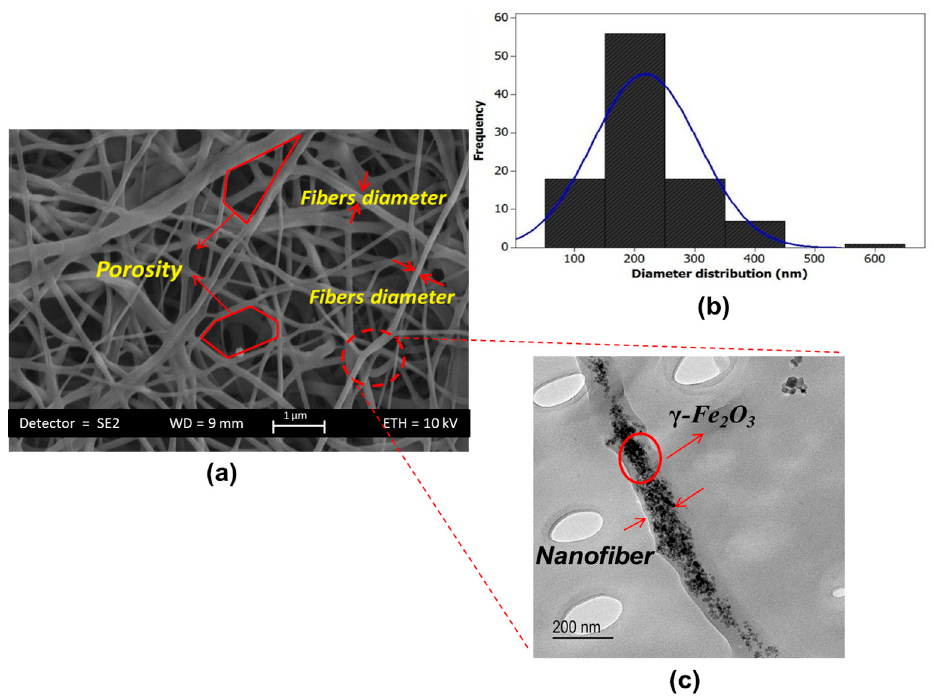
Figure 6. ( a ) FE-SEM image of TPU/PLLA-( γ -Fe 2 O 3 ) nanofibers; ( b ) plot of diameter distribution; and ( c ) TEM image.